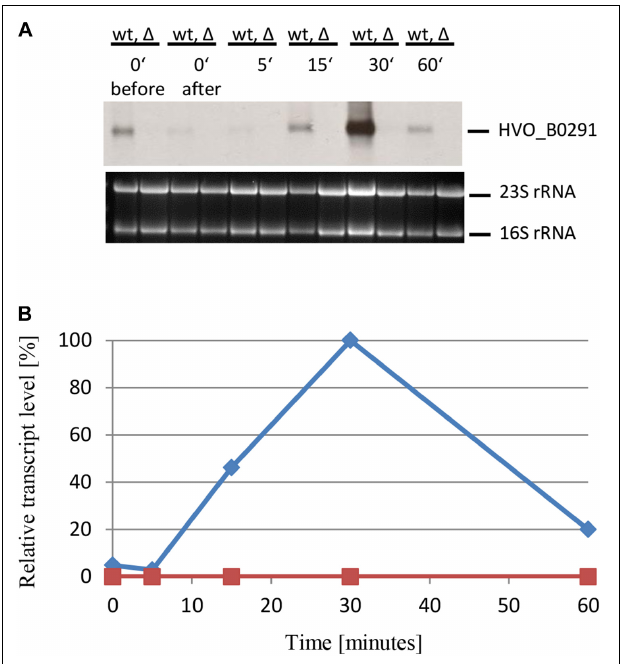
FIGURE 9 | Kinetic analysis of the HVO_1650 mRNA level after the onset of phosphate starvation. (A) HVO_1650 encodes a polyphosphate kinase. The wild-type (wt) H26 and the sRNA132 gene deletion mutant ( (cid:49) ) were grown to mid-exponential growth phase in the presence of phosphate (1 mM). The cells were harvested and resuspended in phosphate-free medium. At the time points indicated at the top aliquots were removed, RNA was isolated and used for Northern blot analysis with an HVO_1650-specific probe. Ethidium bromide stained 23S and 16S rRNAs are shown at the bottom. (B) The signals of the Northern blots were quantified densitometrically, and the kinetic changes of relative transcript levels are